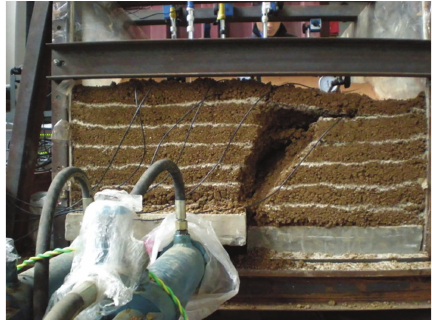
Figure 6: Simulation test of fault slip.